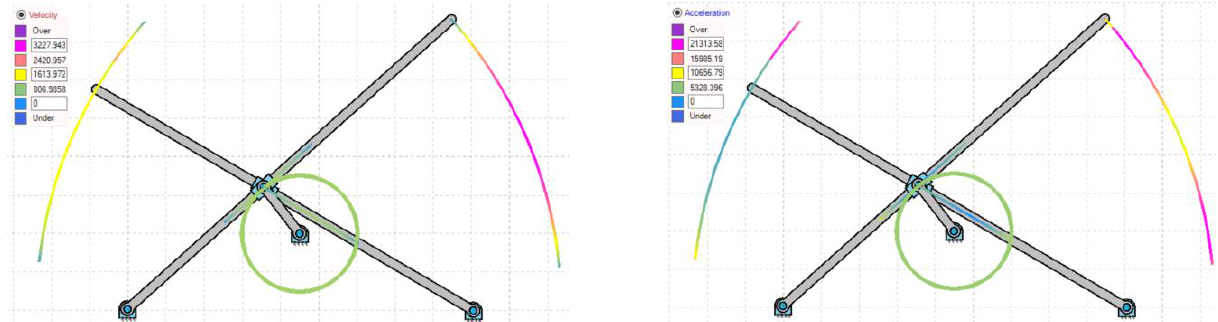
Figure 4. Color representation of variations in velocity and acceleration of design mechanism-I, at both lever paths of motion.